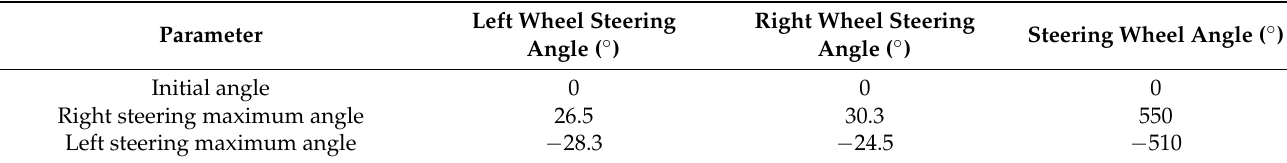
Table 10. Maximum steering angle test